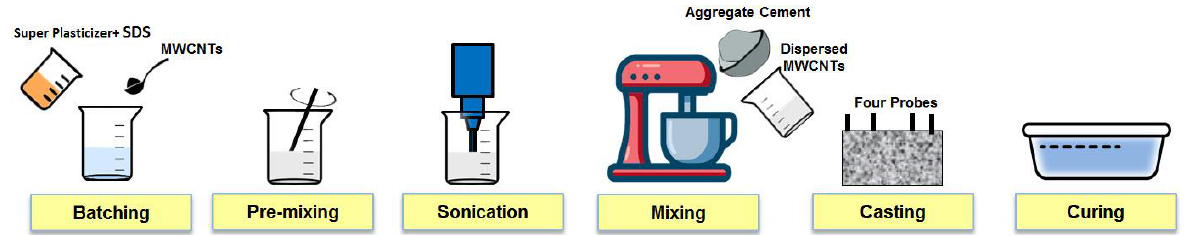
Figure 3. Cement-based concrete sensor preparation steps.